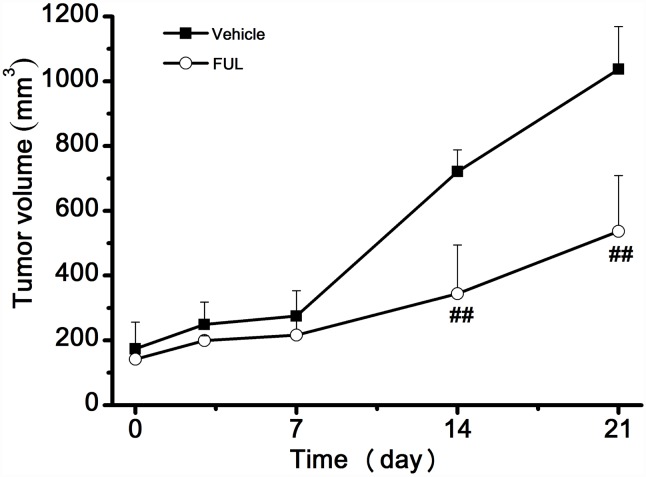
Effect of endocrine therapy on the growth of ZR-75-1 xenografts.** P< 0.001 compared to the vehicle group.